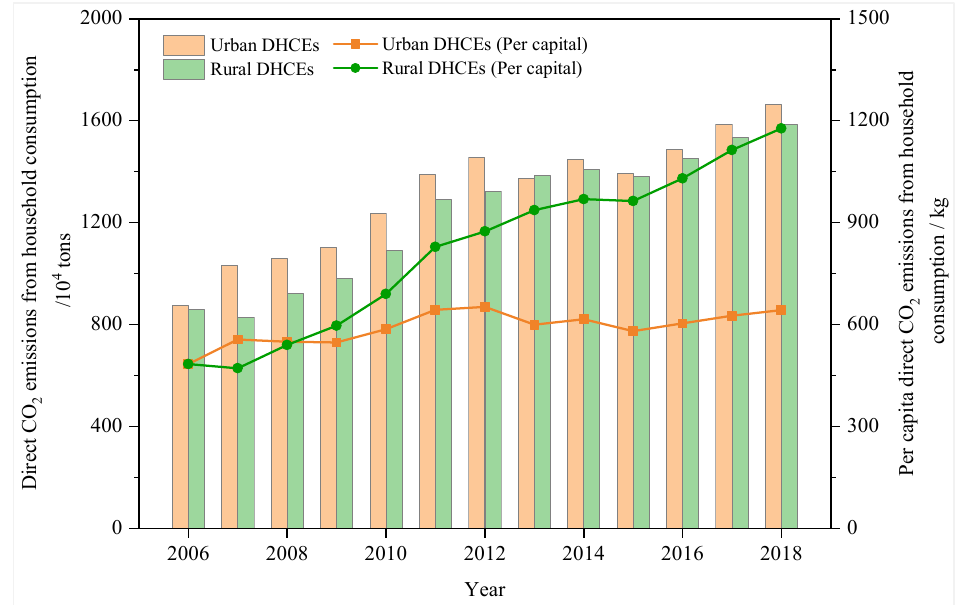
Figure 5. Direct CO 2 emissions from household consumption in Fujian province.